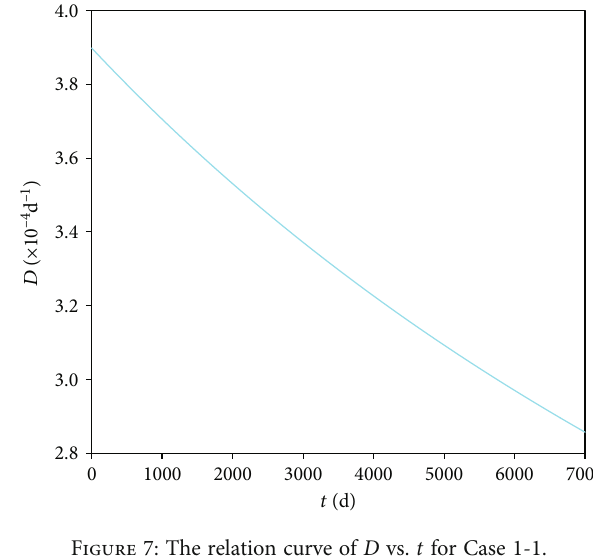
Figure 7: The relation curve of D vs. t for Case 1-1.